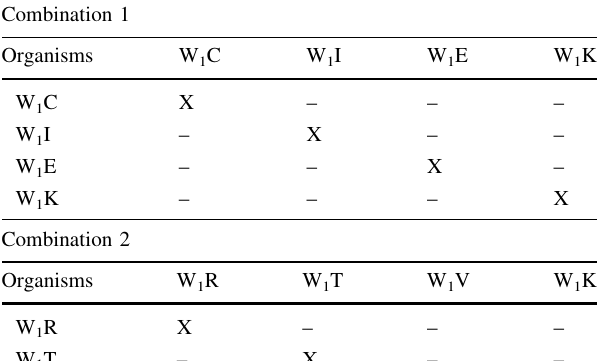
Table 5 Antagonism assay for the proposed microbial